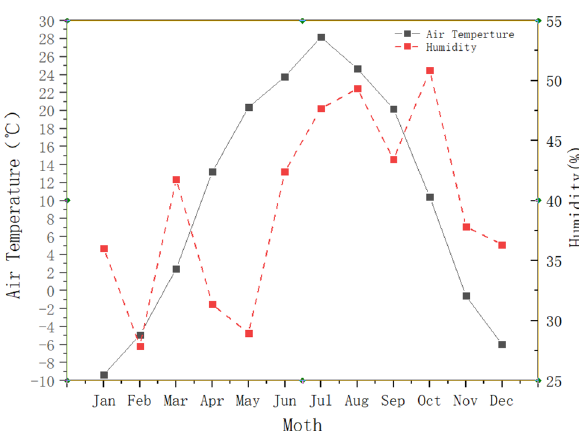
Figure 4. Monthly average changes of temperature and humidity.